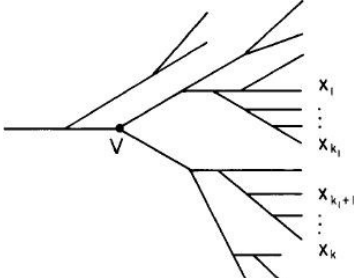
Fig. 1. A schematic diagram to represent a typical production tree ‡